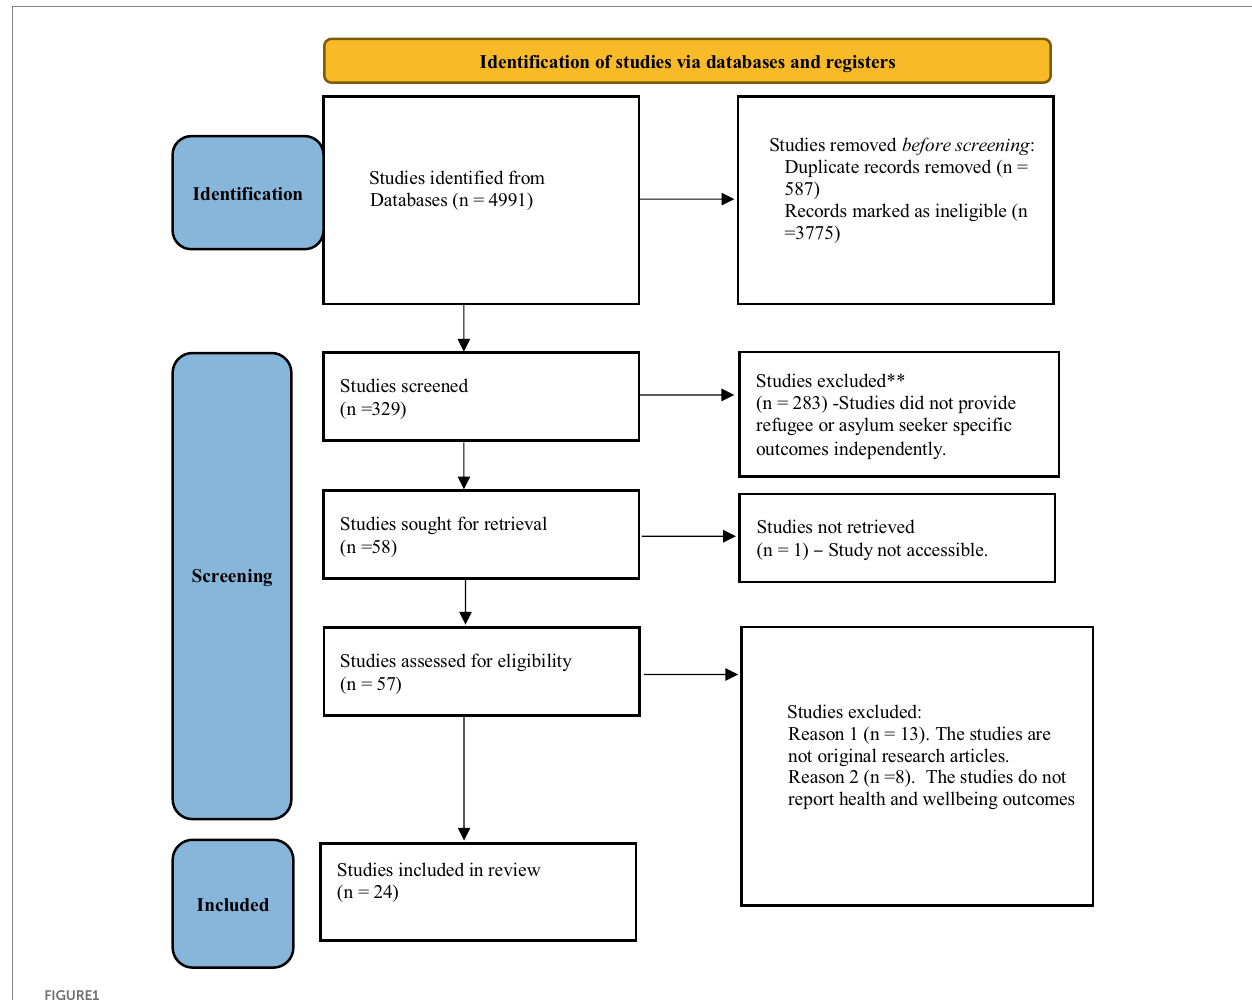
FIGURE1 PRISMA Flow